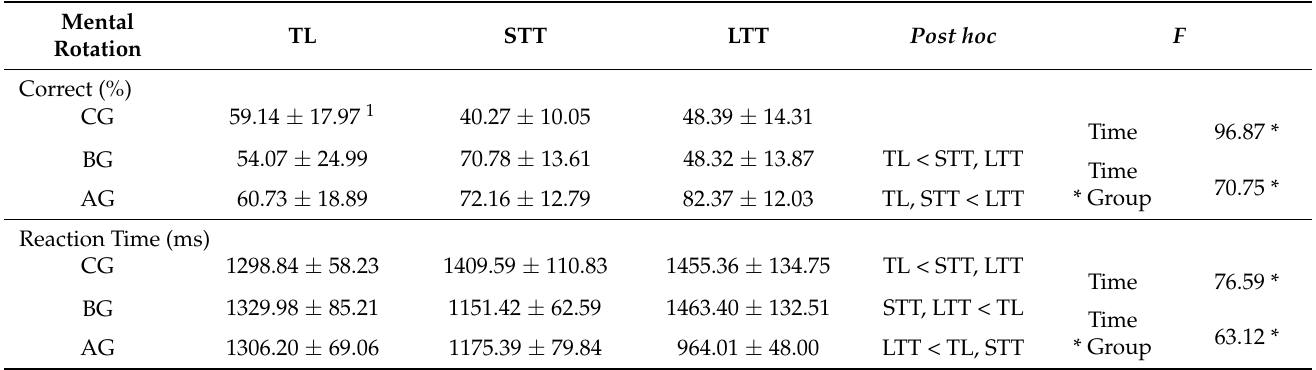
Table 5. Change of spatial perception of cognitive function by area (N =